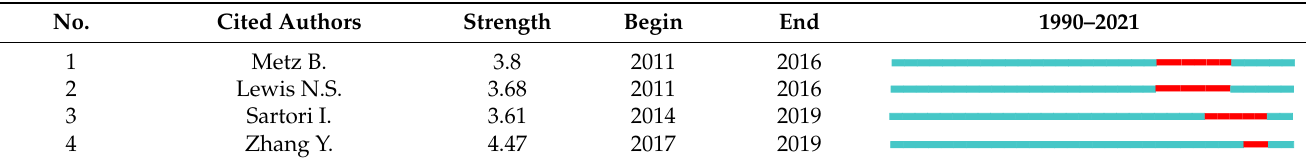
Table 9. Top 4 Cited Authors with the Strongest Citation Bursts.